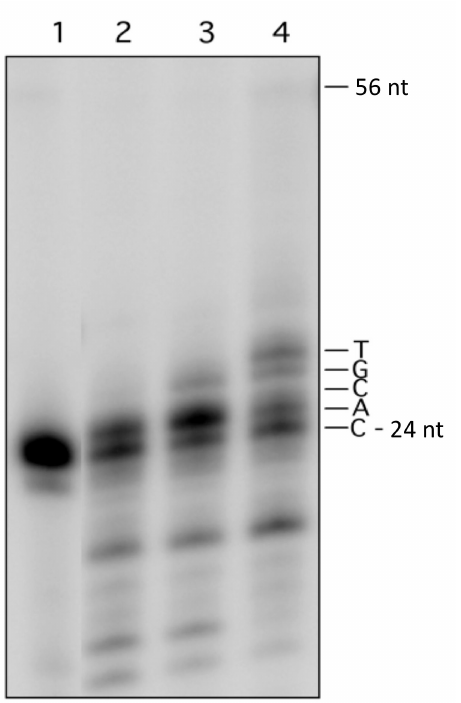
Figure 5. Repair synthesis at MDS1 by yeast whole-cell extract. MDS1 duplex labeled at the 5 (cid:48) end of the 24 mer strand carrying fU were incubated with (lanes 2–4) or without (lane 1) yeast whole-cell extract in the absence of additional dNTP, other than those likely present in the extract (lane 2), in the presence of 20 µ M dATP (lane 3) or 20 µ M of 4 dNTP (lane 4). A full-length DNA product that could possibly represent synthesis and ligation at the 1 nt gap or a full copy of the oG-containing strand was not observed. Note that bands below the 24 mer in lanes 2–4 are degradation products, due to exonucleases in the extract, which were activated in the presence of MgCl 2 in the reaction